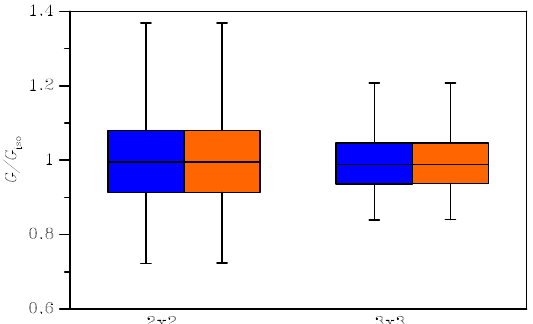
Figure 8. Box-whisker plot for the ratio between G / G iso (blue: uniform strain BCs; orange: uniform stress